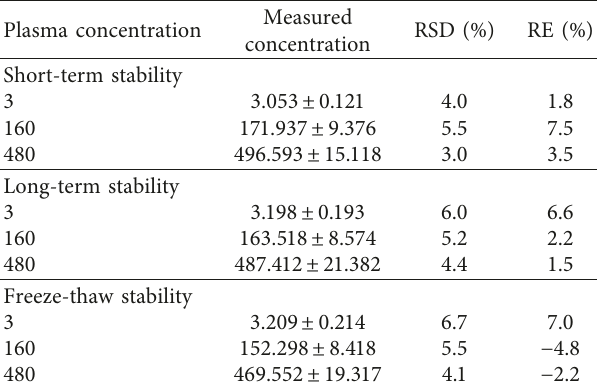
Table 3: Stability of MG in rat plasma ( x ± s ng/mL). Plasma concentration